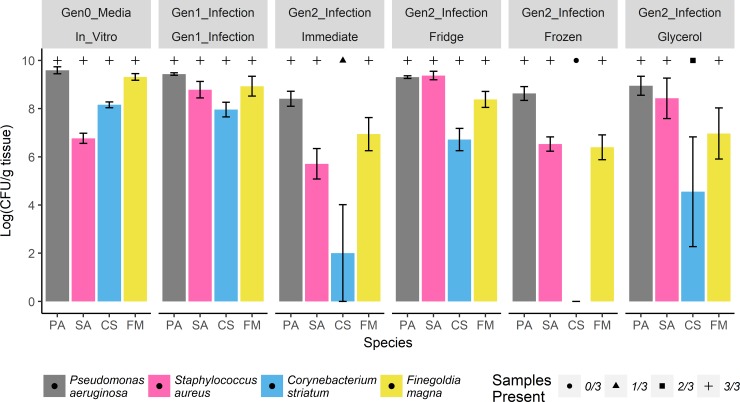
Polymicrobial samples are viable through freezing.Bar plot of species abundances across three mouse replicates (Mean +/- Standard Error). Samples are grouped by community generation and preservation treatment. Generation zero denotes community synthesis in wound-like media, generation one being infection (without treatment) in a mouse, and generation two being infection onto subsequent mice after wound slough extracted from generation one mice received each preservation strategy. Shapes above individual bars indicate the number of mice which a particular species was detected by CFU count.